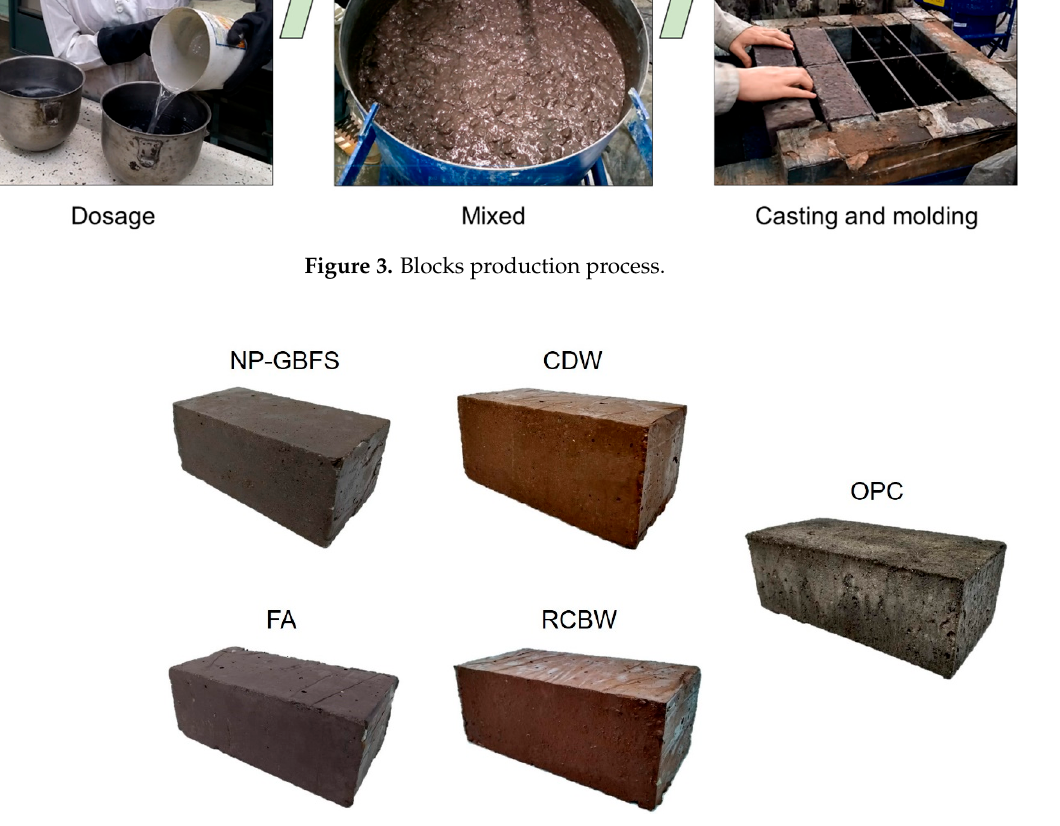
Figure 3. Blocks production process.